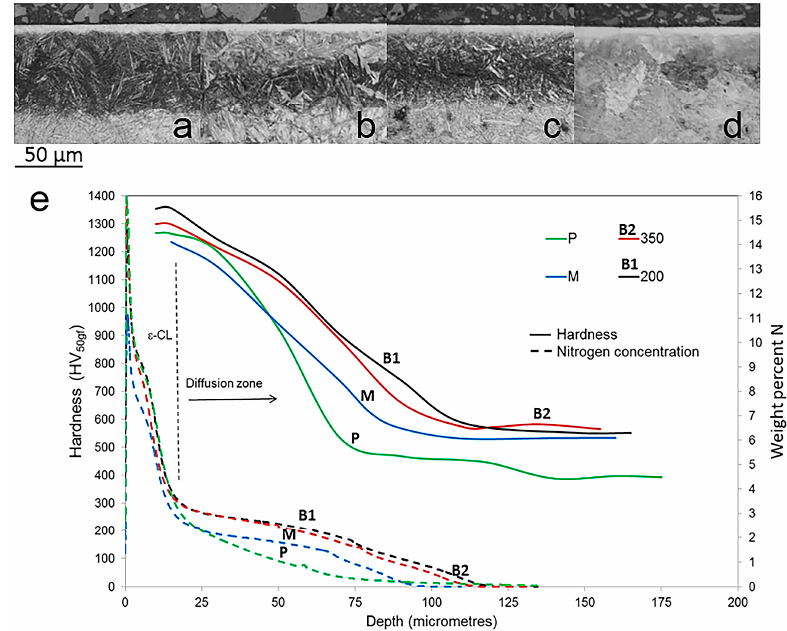
Figure 5. Nitrocarburised microstructures of ( a ) ‘200’ bainite (B1), ( b ) ‘350’ bainite (B2), ( c ) ‘M’ ( d ) ‘P’ and ( e ) quantitative depth profiles of nitrogen and hardness profiles in the nitrocarburised surface of all the microstructural variants.